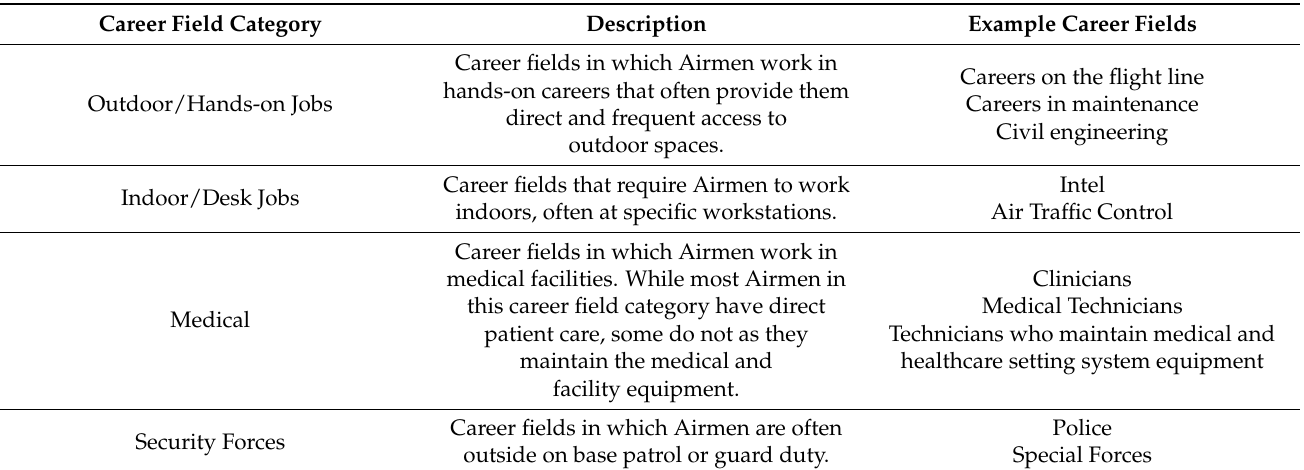
Table 1. Identified Career Field